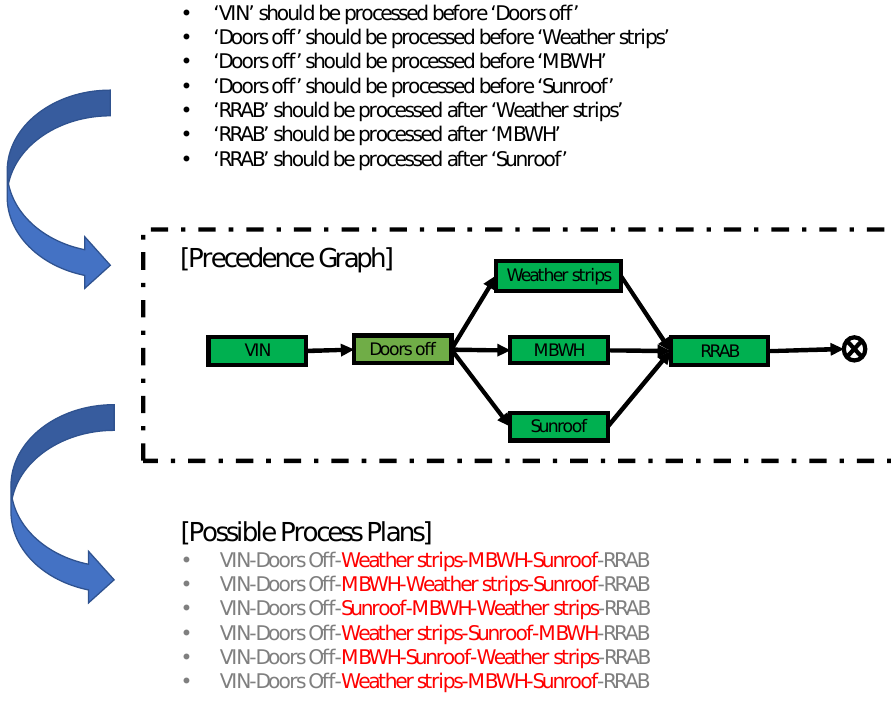
Figure 6. Operation flexibility example. Figure 6. Operational flexibility